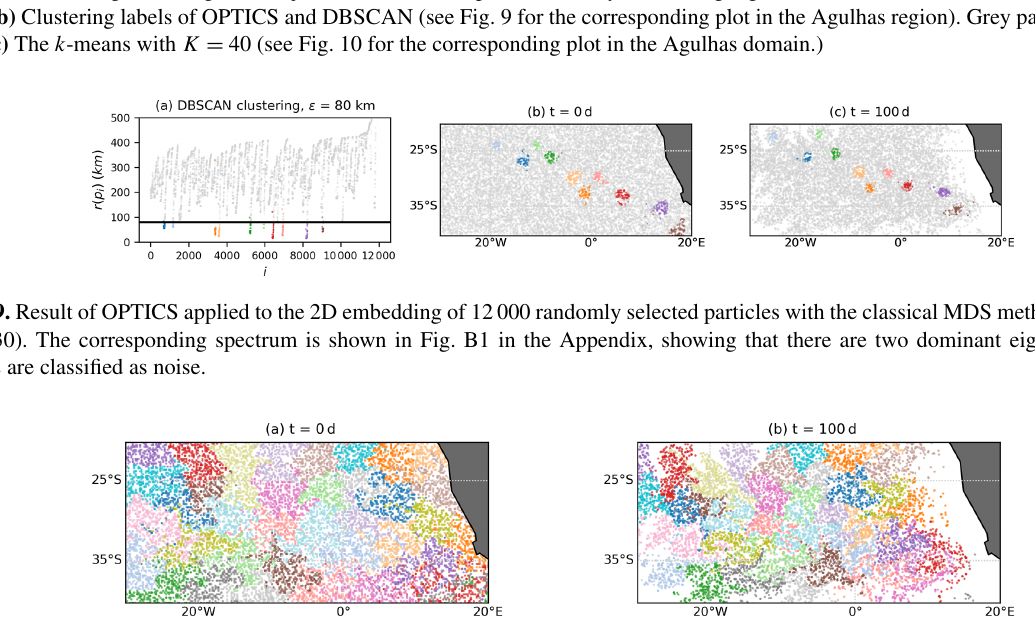
Figure 10. Result of the k -means clustering, with K = 40 applied to the 2D embedding with classical MDS (see Fig.